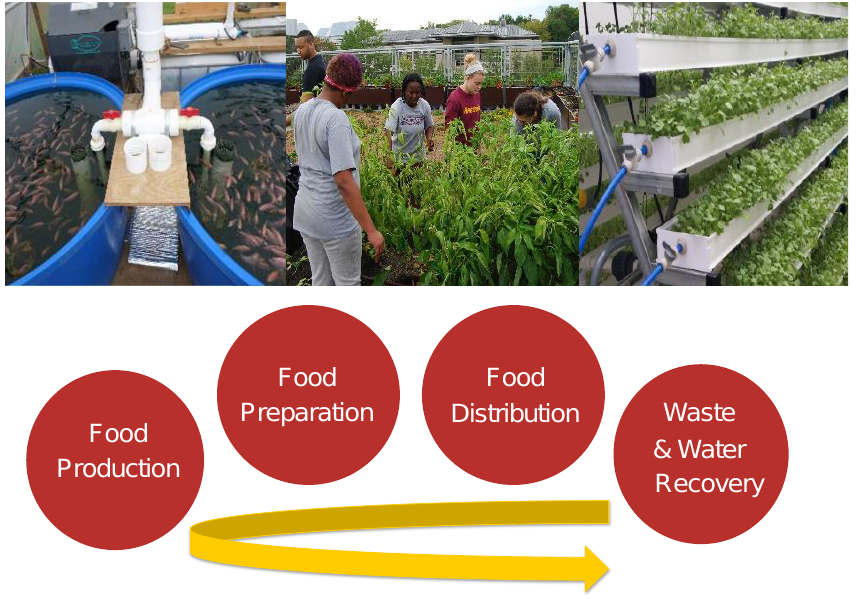
Figure 1. The UDC CAUSES Urban Food Hubs Model [36].